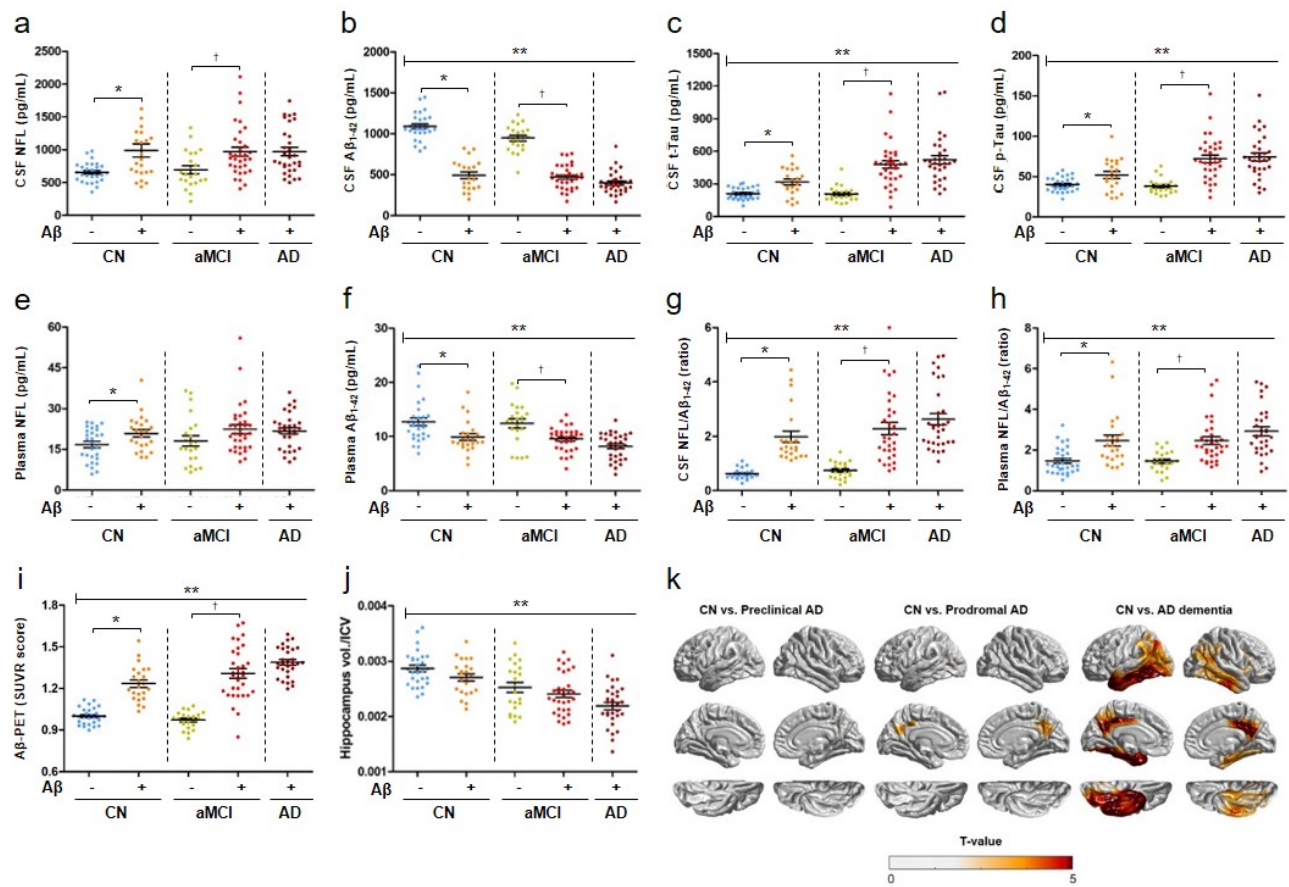
Figure 1. Biomarker concentrations in the CSF, plasma, and neuroimaging data. Data are presented as mean values of ATN (amyloid, tau, and neurodegeneration) biomarker concentrations in the CSF ( a d ), plasma neurofilament light chain (NFL) concentrations ( e ), plasma A β 1–42 concentrations ( f ), CSF NFL/A β 1–42 ( g ), plasma NFL/A β 1–42 ( h ), standard uptake value ratio (SUVR) scores ( i ), and value of hippocampal volume/intracranial volume (ICV) ( j ). Statistical analysis was performed using SPSS version 25. ** p < 0.001, statically significant group effect by ANOVA [groups: cognitively normal (CN) (n = 51), amnestic mild cognitive impairment (aMCI) (n = 54), and Alzheimer’s disease (AD) dementia (n = 31)]. * p < 0.005, † p < 0.05, significant difference between two indicated groups using ANCOVA adjusted for age and sex. ( k ) Brain cortical atrophy patterns as t ‐ value maps in the preclinical AD, prodromal AD, and AD dementia groups. Preclinical AD (CN A β +) (n = 23), prodromal AD (aMCI A β +) (n = 32), and AD dementia (AD A β +) (n = 30) groups were compared with the CN A β− (n = 28) group to observe differences in point ‐ wise cortical thickness using a general linear model with ad ‐ justments for age, sex, and field strength as covariates. Greater cortical atrophy was observed in the AD dementia group.